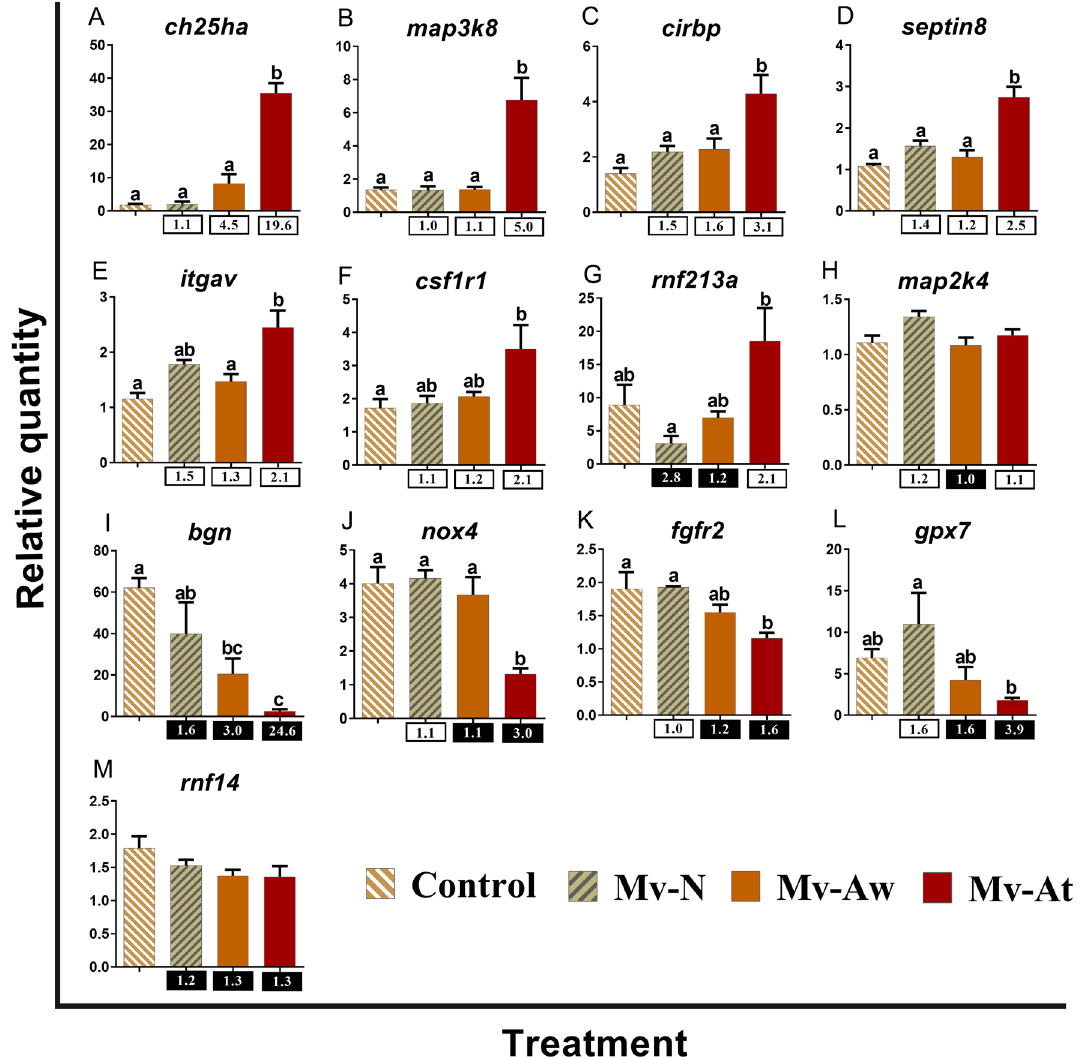
Figure 4. qPCR for M. viscosa -responsive transcripts playing putative roles in regulation of immune and inflammatory responses. The skin samples of M. viscosa -infected Atlantic salmon at the lesion (Mv-At; n = 4) and away (Mv-Aw; n = 4) sites, as well as the samples of fish with no lesion in M. viscosa group (Mv-N; n = 3) and non-infected control group (Control; n = 4), were used for qPCR validation. Data are presented as mean ± SE, with the lowest expressing sample as calibrator [i.e. set to relative quantity (RQ) 1.0]. Letters in each panel indicate significant differences between groups, as determined by one-way ANOVA with Tukey’s post hoc test ( p < 0.05). Fold-changes are shown below the groups, calculated as mean RQ of the group/ mean RQ of the control. Black boxes indicate the down-regulated or negative fold-changes, which were calculated as 1/fold- change for comparisons that yielded fold-change values less than 1. Gene symbols are shown at the top of each panel ( A – M (Fig. 5K). On the other hand, matrix metalloproteinase-19-paralogue b ( mmp19-b ) expression was suppressed with M. viscosa infection in both lesion, and away sites (i.e. Mv-At and Mv-Aw) compared to the control (Fig. 5L). There were lower levels of tapasin ( tapbp ) in Mv-N and Mv-At groups than in the control group (Fig. 5M). C–C motif chemokine 17 ( ccl17 ) and sestrin-1 ( sesn1 ) were significantly down-regulated in response to M. viscosa infec- tion at the lesion site compared to the Mv-Aw and control samples (Fig. 5N,O). C–C motif chemokine 19-paral- ogue b ( ccl19-b ) expression was significantly suppressed in Mv-At compared with control samples (Fig. 5P). The significant down-regulation of C–C motif chemokine 20 ( ccl20 ) by M. viscosa infection was only seen between the Mv-At and Mv-N groups (Fig. 5Q). Principal component analysis (PCA) was performed to examine the association of Atlantic salmon and M. viscosa transcripts studied herein, and it exhibited a clear separation among the experimental groups (Fig. 6). PC1 (i.e. 64.9% of total variation) and PC2 (i.e. 10.5% of total variation) cumulatively explained 75.4% of the total variation. The Control, Mv-Aw and Mv-N samples were positively loaded on PC1, whereas Mv-At samples were negatively loaded on PC1 (Fig. 6). While the lesion site infection samples (i.e. Mv-At) associated with the left side vectors such as crem , irf7 , tlr5 , csf1r1 and ch25ha as well as the M. viscosa transcripts (i.e. glyA, rpoB,